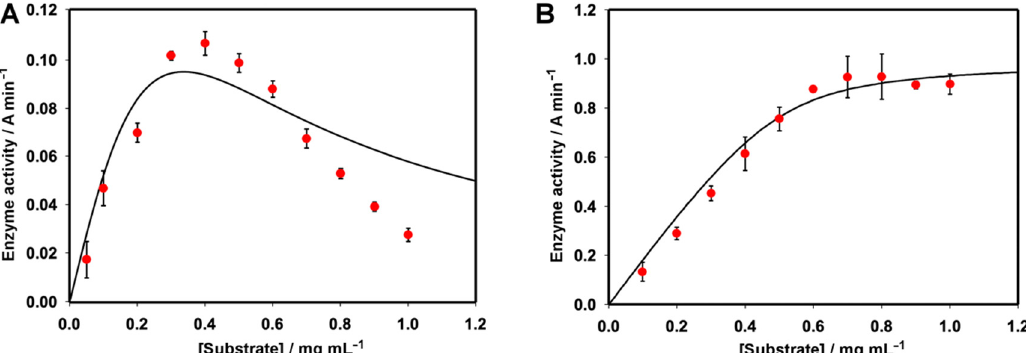
Figure 4. ( A ): Effect of the substrate concentration on ( A ) Slt35 and ( B ) lysozyme activity. For Slt35, the 7 μ M enzyme was used at 37 °C in 25 mM Tris-maleate (pH 5.8) containing 10 mM CaCl 2 . A fit to an expression for substrate inhibition [40] is shown. For lysozyme, 0.1 μ M enzyme was used at 37 °C in 25 mM Tris-maleate (pH 6.0) containing 100 mM KCl. A fit to the Morrison equation for the tight-binding substrate [41] is shown.